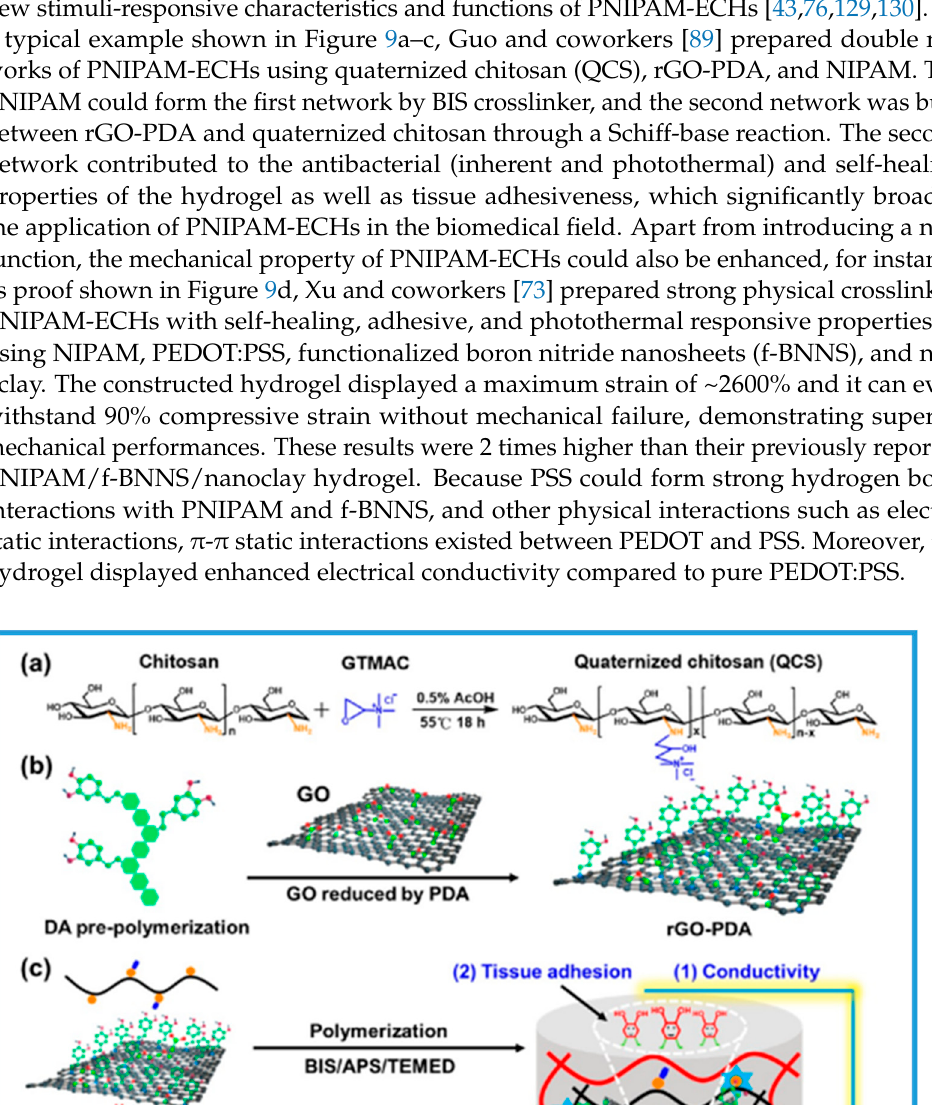
Figure 9. ( a ) Illustration of preparation process of quaternized chitosan. ( b ) Illustration of prepara- tion process of rGO-PDA. ( c ) Illustration of preparation process of PNIPAM-ECH with quaternized